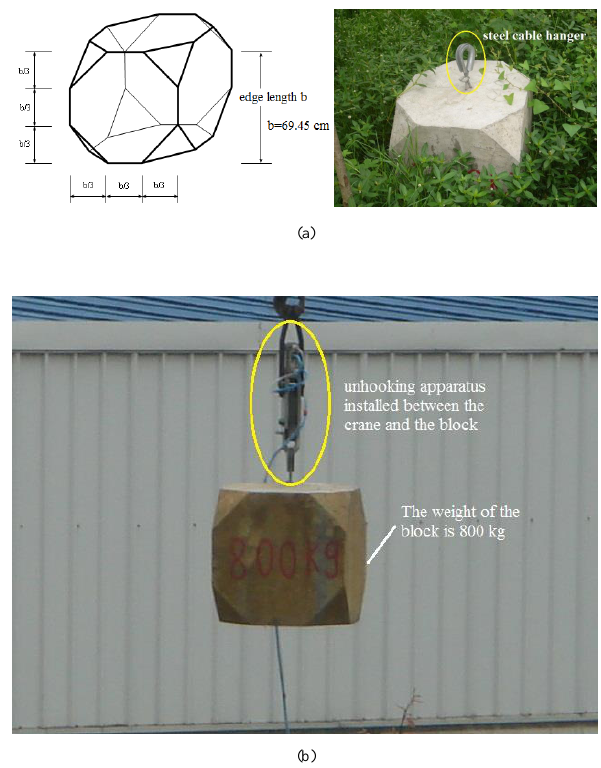
Fig. 5. (a) Cubic block of 14-face polyhedron; (b) An unhooking apparatus installed between the crane and the block